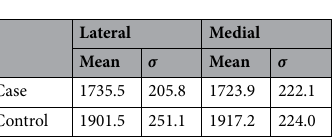
Table 2. Statistics of pixel brightness in lateral and medial